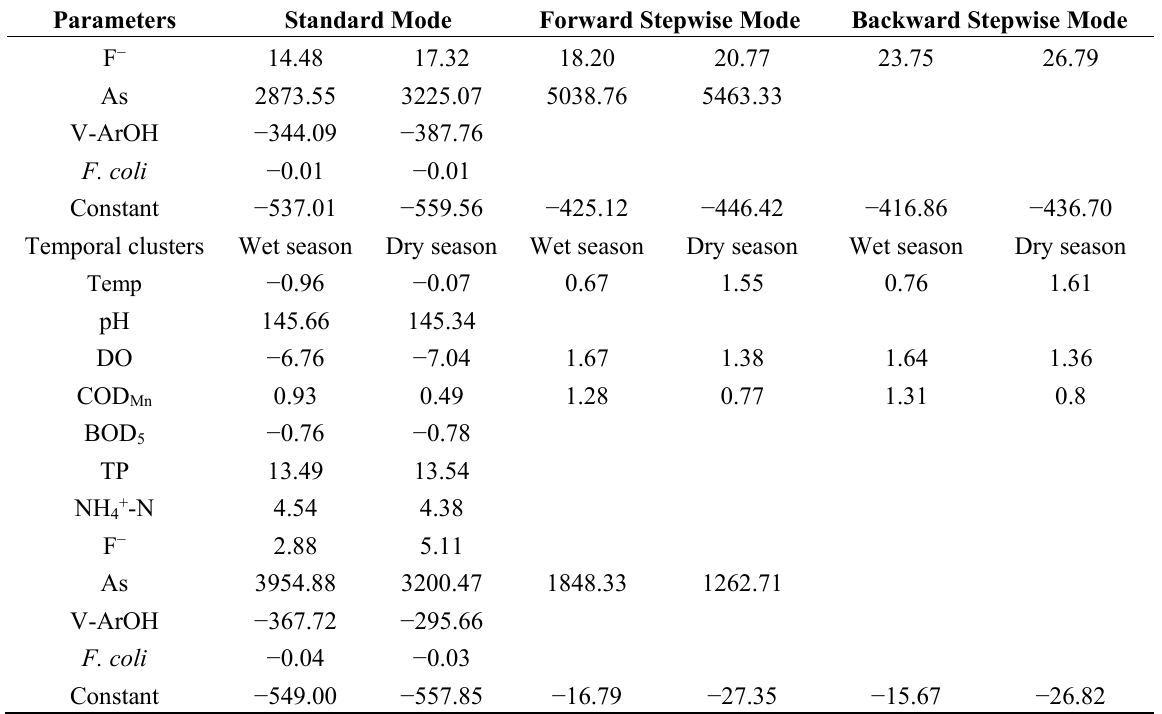
Table 6. Classification matrixes for discriminant analysis of spatial and temporal variations. Monitoring